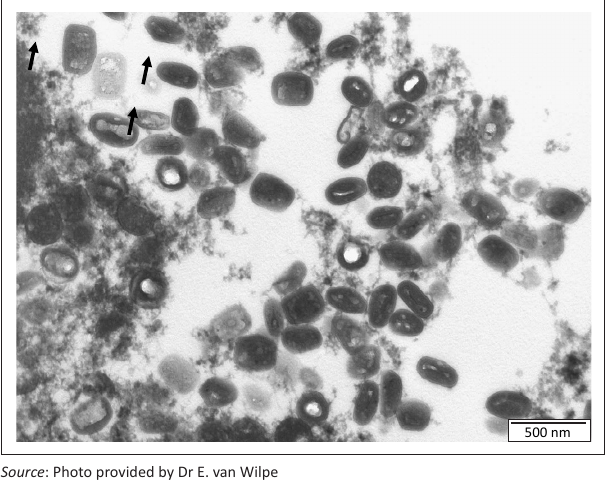
FIGURE 3 : Electron microscopic appearance of cytoplasmic Poxvirus particles in affected skin. Source : Photo provided by Dr E. van Wilpe. Note: Arrows show characteristic brick-shaped particles.